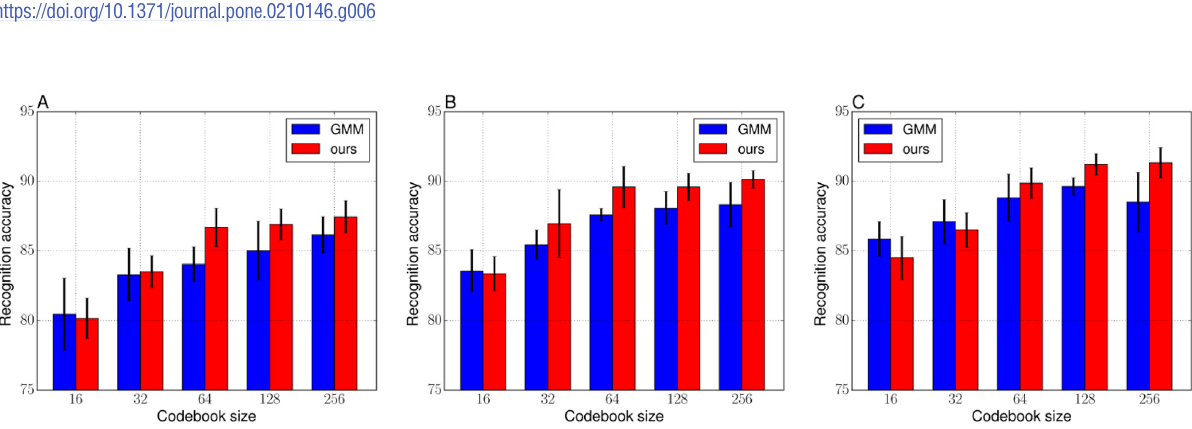
Fig 7. Recognition accuracies of the FVs with the GMM and ours (soft objective) codebooks on the Butterflies. (A) 20 images per category for training. (B) 30 images per category for training. (C) 40 images per category for training.